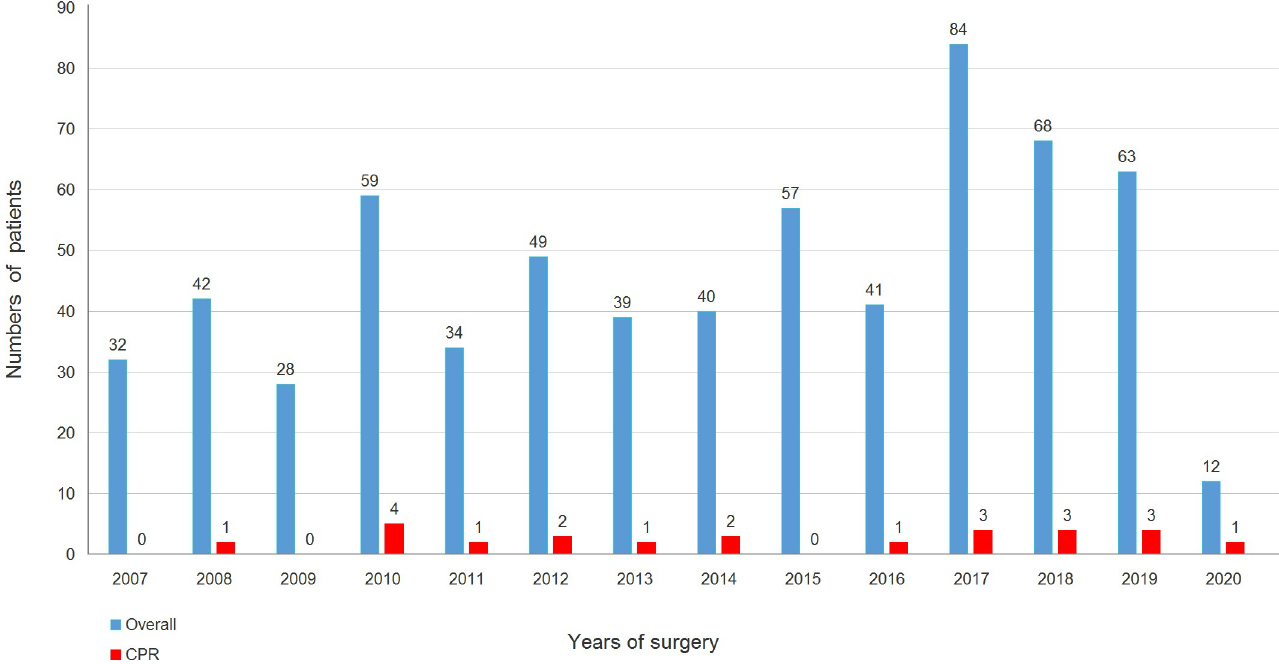
Fig 1. Distribution of ATAAD patients during the study period. ATAAD, acute type A aortic dissection.